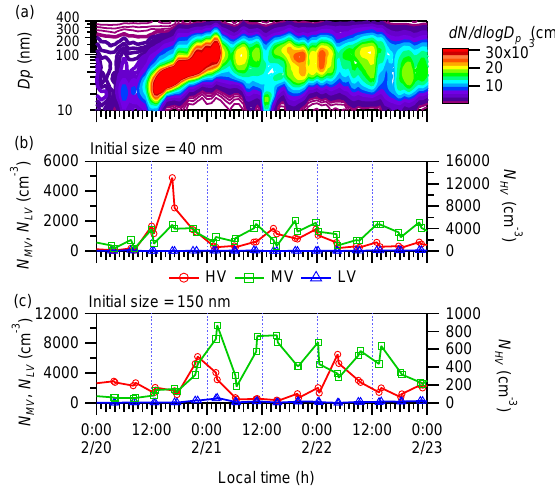
Figure 10. Time series of (a) particle number size distribution, (b) number concentrations of HV, MV and LV in 40nm particles and (c) number concentrations of HV, MV and LV in 150nm parti- cles during a new particle event day on 20 February